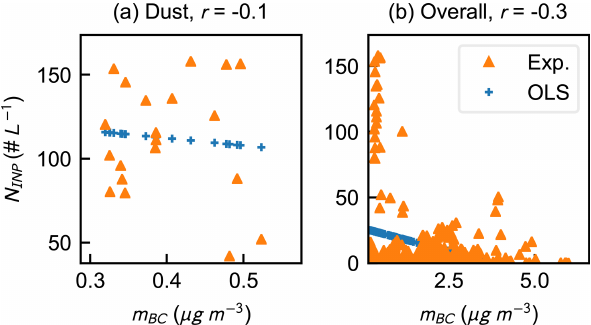
Figure C4. Correlations between m BC and N INP during the (a) dust event and (b) observation. The r above each panel is Pearson’s correla- tion coefficient. Blue markers indicate the predicted N INP using fitted linear regression parameters.